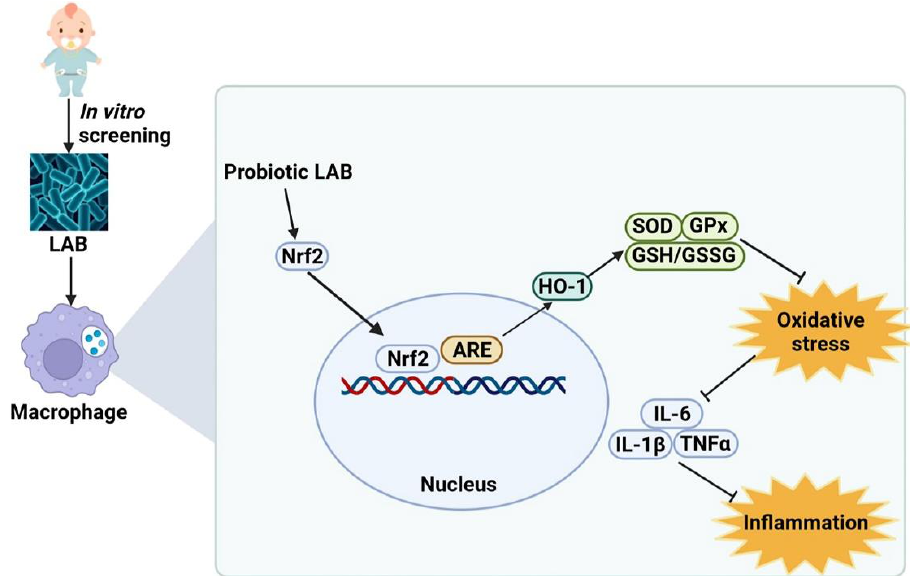
Figure 7. Proposed molecular mechanisms underlying the inhibitory effect of LAB (isolated from infant feces) on the activation of macrophages induced by LPS. LAB activates Nrf2/HO-1 pathway to regulate cellular redox status and reduce oxidative stress, which in turn inhibits inflammation.